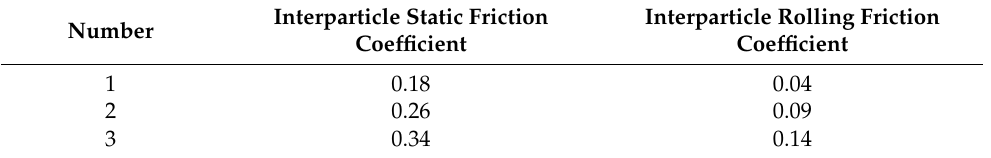
Table 3. Experimental design.